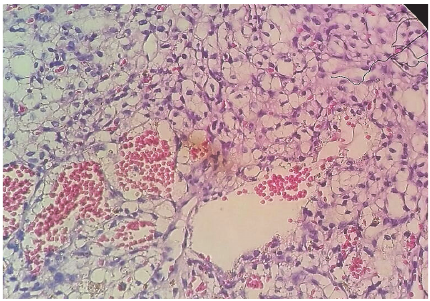
Figure 1: Noncontrast CT scan: water density renal mass, compati- ble with a simple renal cyst.